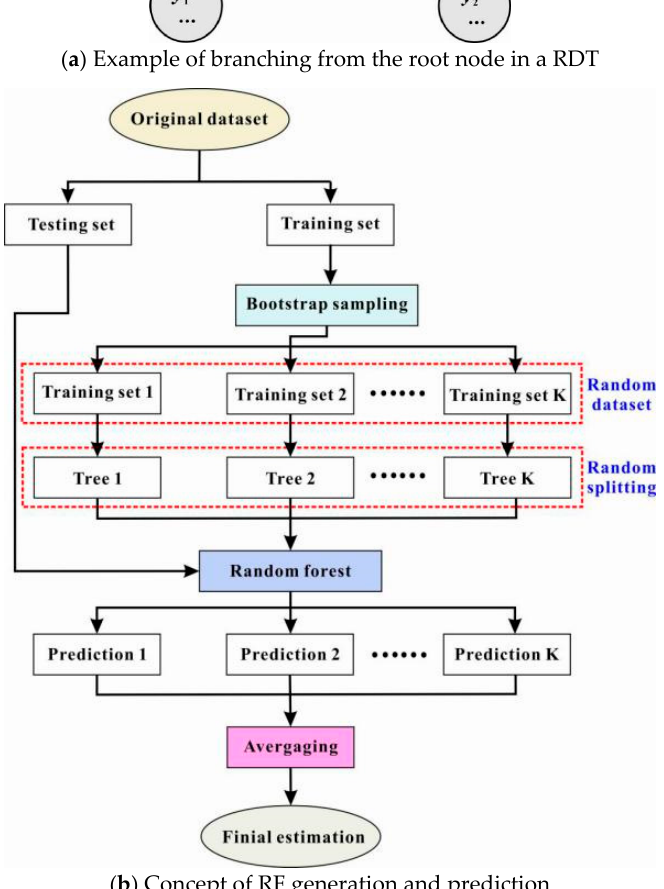
Figure 4. Schematic illustrations of regression decision tree (RDT) and random forest (RF).